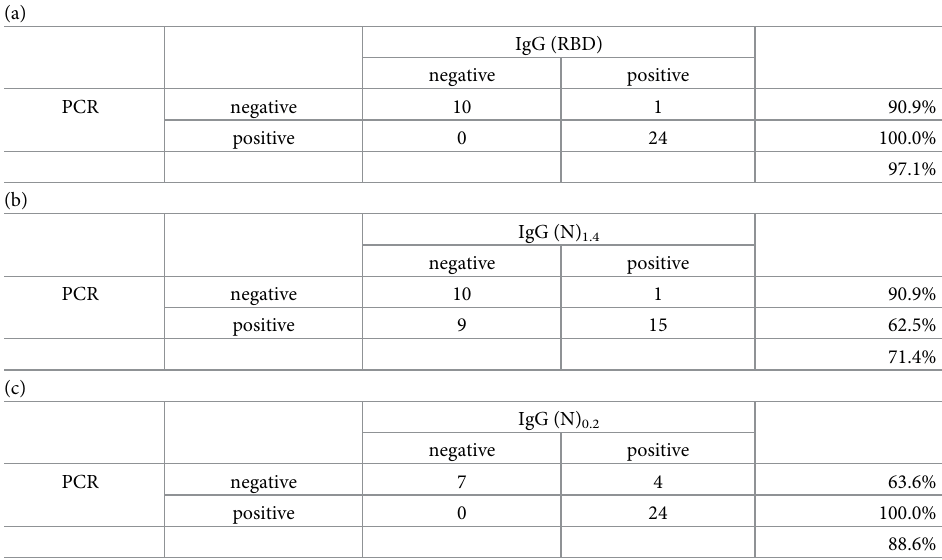
Table 4. Sensitivity, specificity, and concordance of IgG (RBD), IgG (N) 1.4 , and IgG (N) 0.2 against